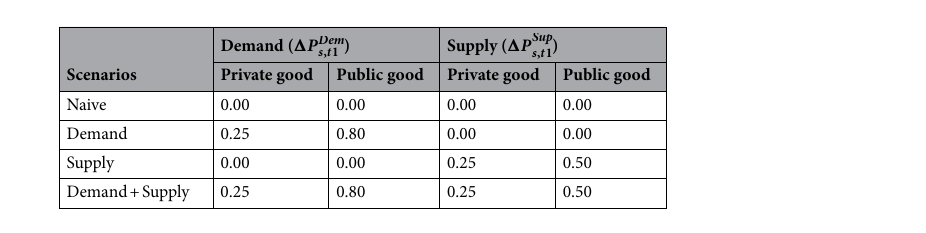
Table 2. Relative changes of scarcity value under four scenarios.